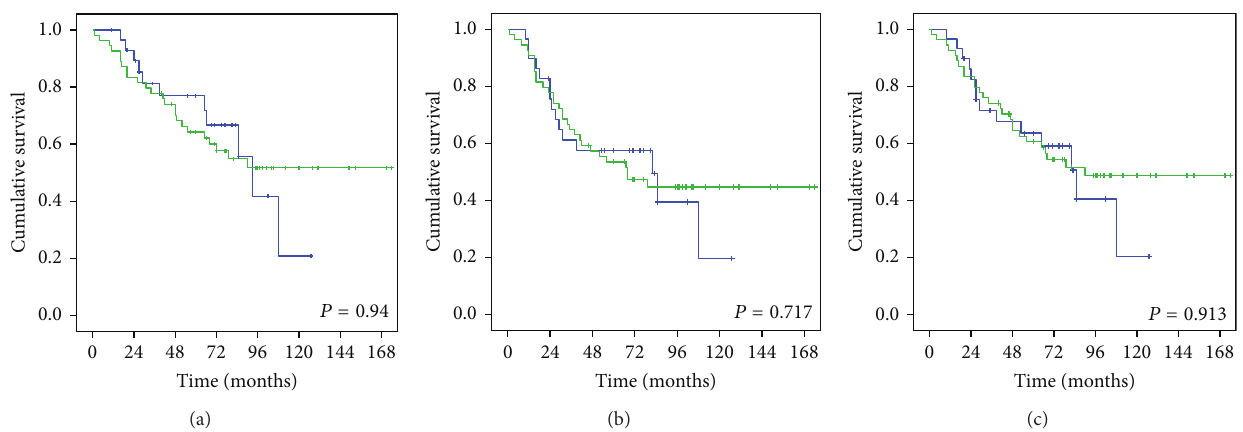
Figure 2: Comparison of (a) the 5-year overall survival, (b) the 5-year locoregional-free survival, and (c) the 5-year disease-free survival in T4-locally advanced NPC patients with cranial nerve involvement (green line) or without cranial nerve involvement (blue line).